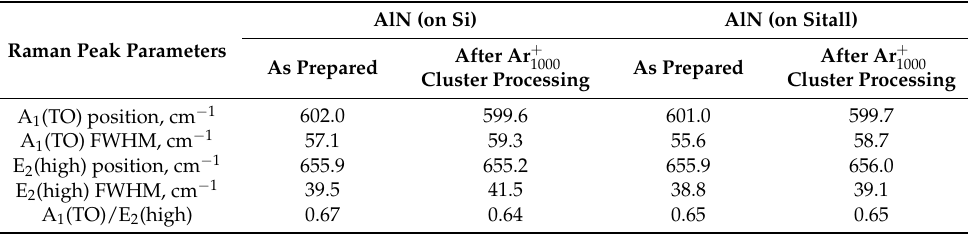
Table 2. Raman band parameters and A 1 (TO)/E 2 (high) intensity ratios for the AlN films. AlN (on Si) AlN (on Raman Peak Parameters